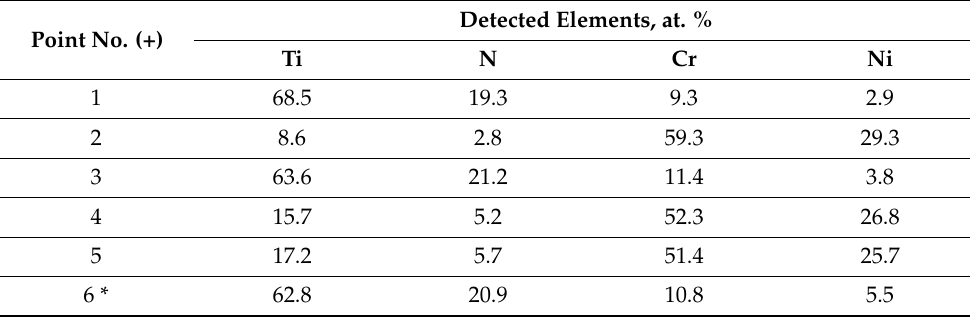
Table 4. Results of the X-ray diffraction analysis of the materials obtained by direct laser deposition from CrxNiy-TiN SHS composites. Phase Content, Lattice CSR Size, nm Sample Detected Phases ´ Mass % Parameters, Å TiN_225 70 a = 4.2425 85 Cr x Ni y -TiN CrNi_229 30 a = 2.8877 55